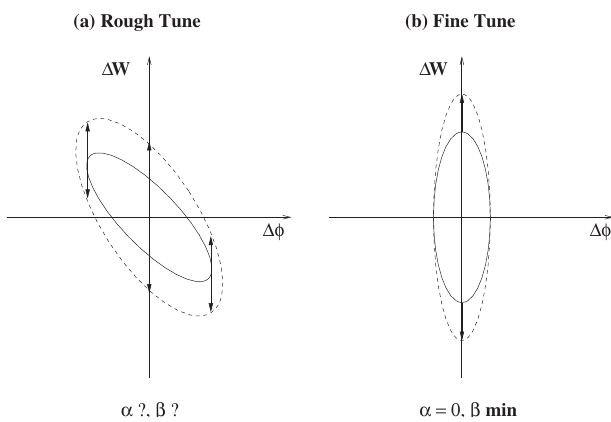
FIG. 3. Criteria for an optimized or fine tune. (a) Shows the longitudinal beam ellipse before (solid) and after (dashed) a stripper for a rough longitudinal tune. (b) Shows the same as (a) but for an optimized tune. We clearly notice that after fine tuning the beam emittance after the stripper is much smaller. Arriving at the stripper with an upright ellipse is